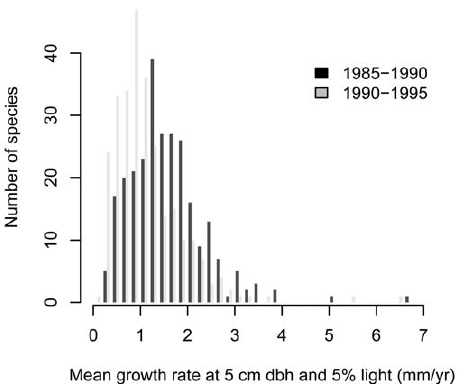
Figure 2. Growth rates at standardized conditions. Predicted annual growth rate (mm/yr) at 5 cm dbh and 5% light for 265 tree species in the census interval 1985–1990 and 270 species in the census interval 1990–1995 at BCI, Panama.